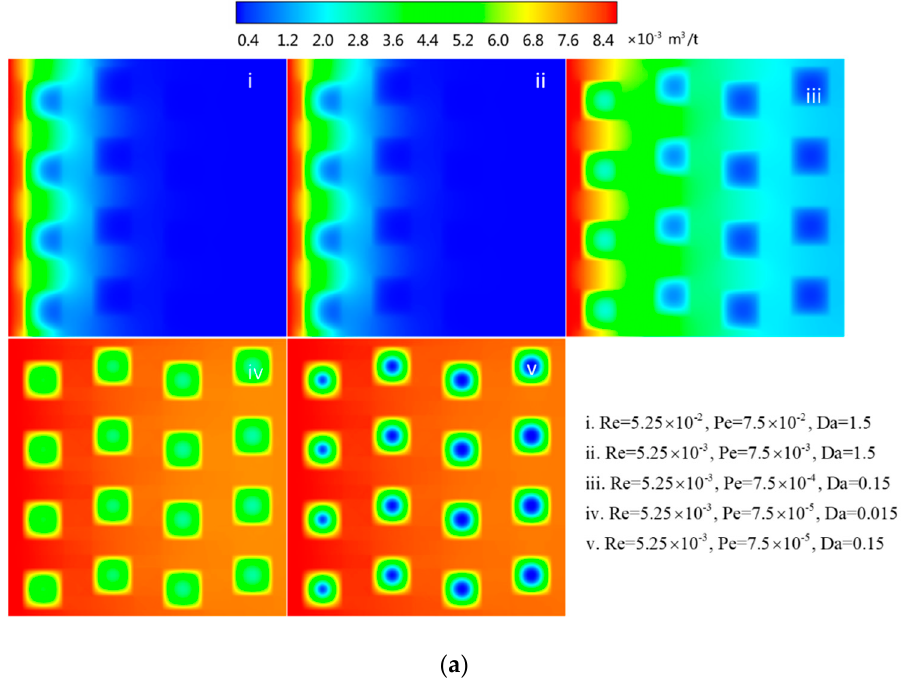
Figure 4. The simplified 2D reconstructed geometry of the coal matrix.